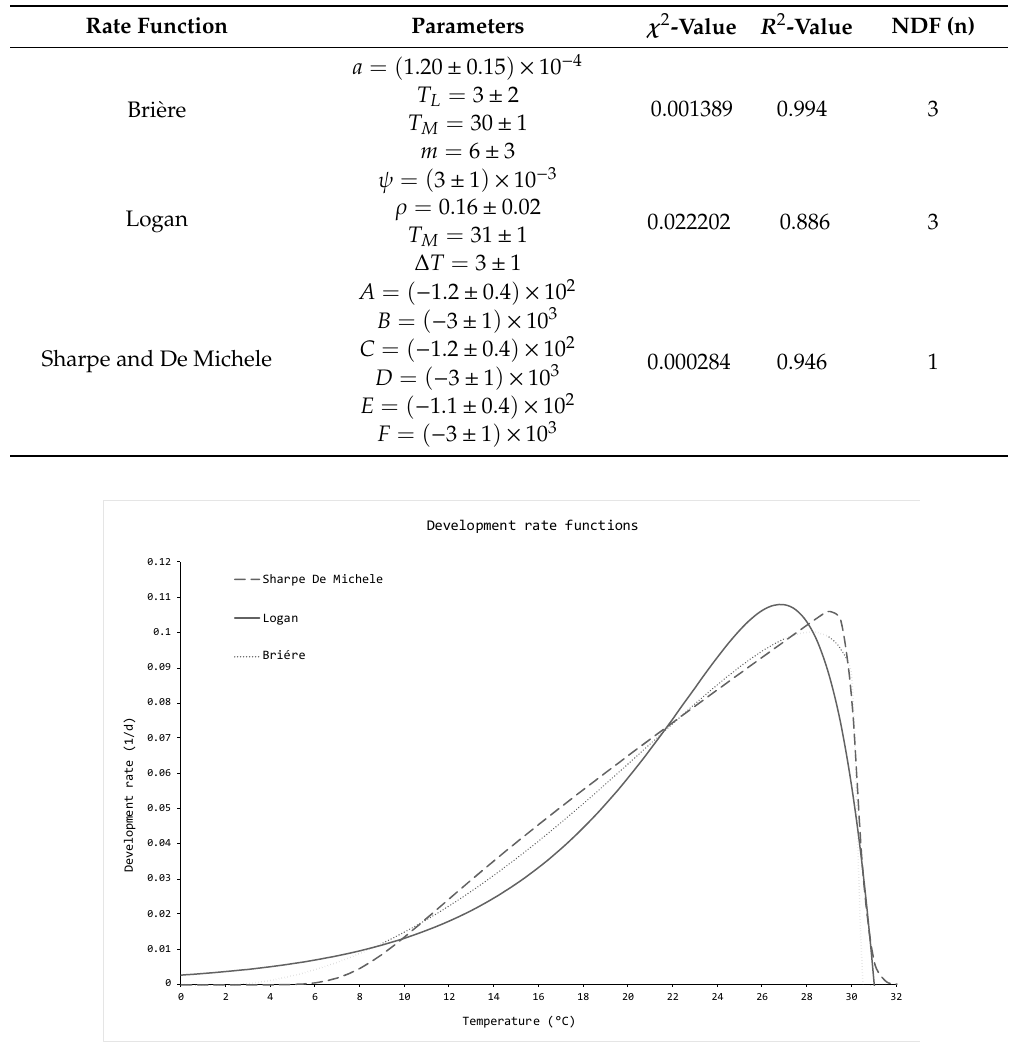
Table 2. Best fit parameters ( ± standard error) of the Briére (3), Logan (4) and Sharpe and De Michele (5) development rate functions estimated with data from Tochen et al. [12]. For each nonlinear regression, the χ 2 -value, the R 2 -value and the number of degrees of freedom (NDF) were reported.